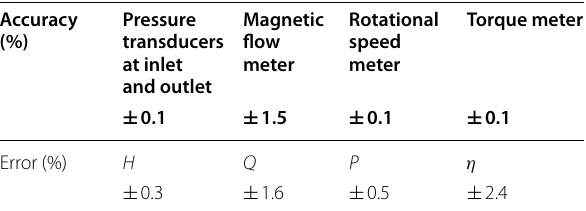
Table 2 Accuracy of each instrument and errors for these calculated parameters